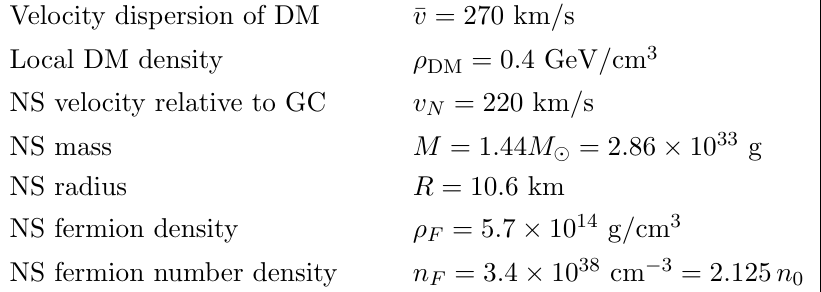
Table 1 . Parameter values for the DM halo and